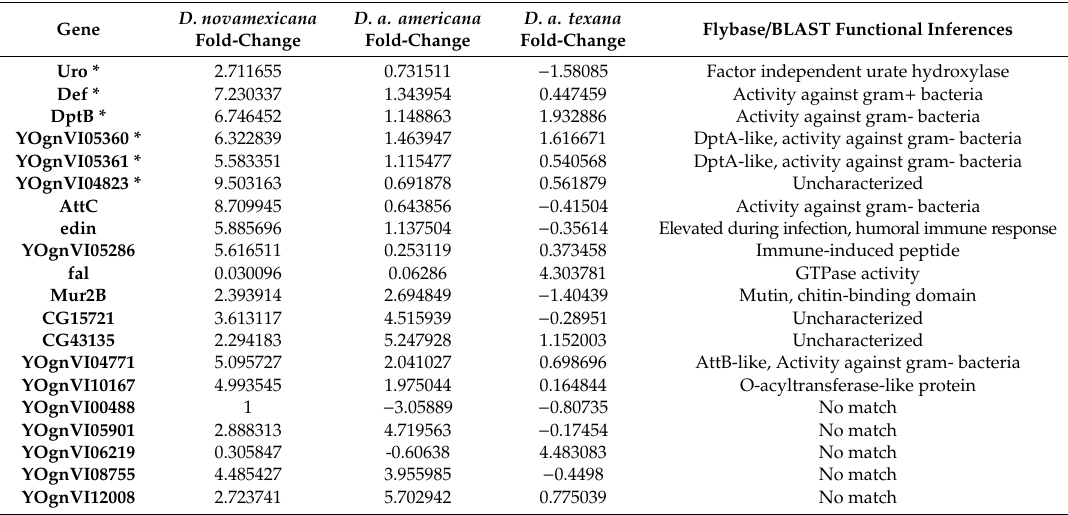
Table 3. Top 20 genes with highest between-species variance in plastic responses to desiccation stress in females, as measured by fold-change in expression between control and desiccation treatments. *Loci also found in top 20 genes for males (Table 2). The next 10 most plastic loci are listed in Supplement Table S2.